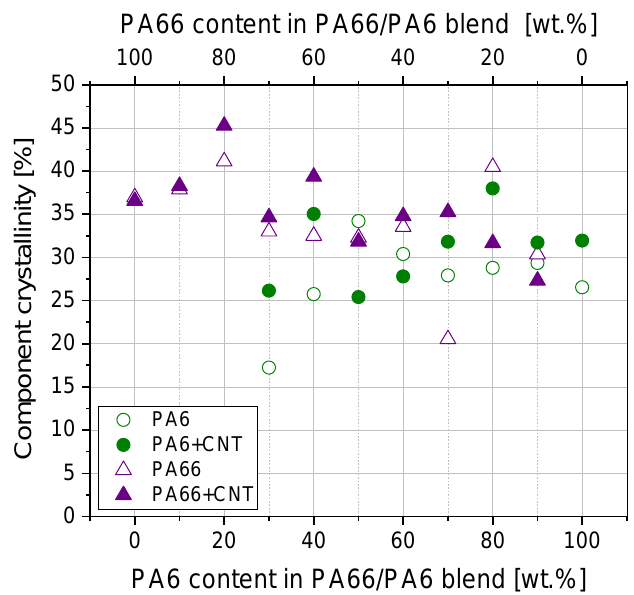
Figure 8. Degree of crystallinity of PA6 and PA66 components in blends without and with 1 wt % MWCNTs. The melting enthalpies attributed to PA6 and PA66 (Table S1) are related to the corresponding content in the blend and the value of 100% crystallinity of that component (calculated using equation (2)).